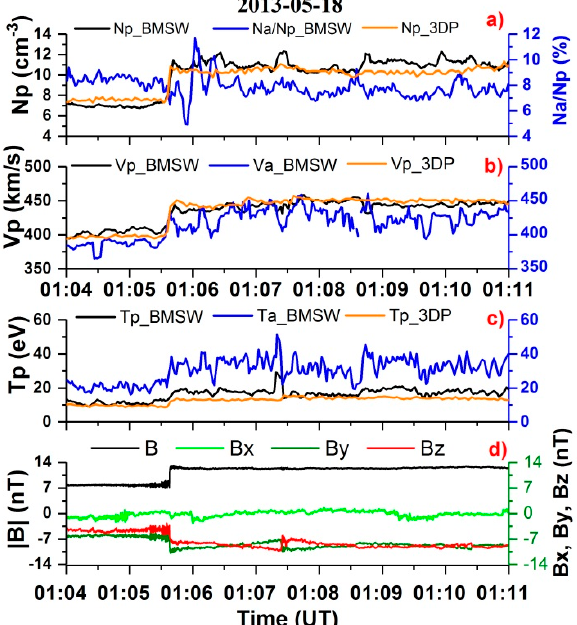
Figure 5. Time profiles for the solar wind plasma parameters and magnetic field during crossing of the IP shock on 18 May 2013: ( a ) densities, ( b ) velocities, ( c ) temperatures, ( d ) magnetic field magnitude and components. Satellites’ coordinates (GSE coordinate system, Re): Spektr-R (26,97; 31,36; − 6,14); WIND (247,97; − 75,68; 18,24).